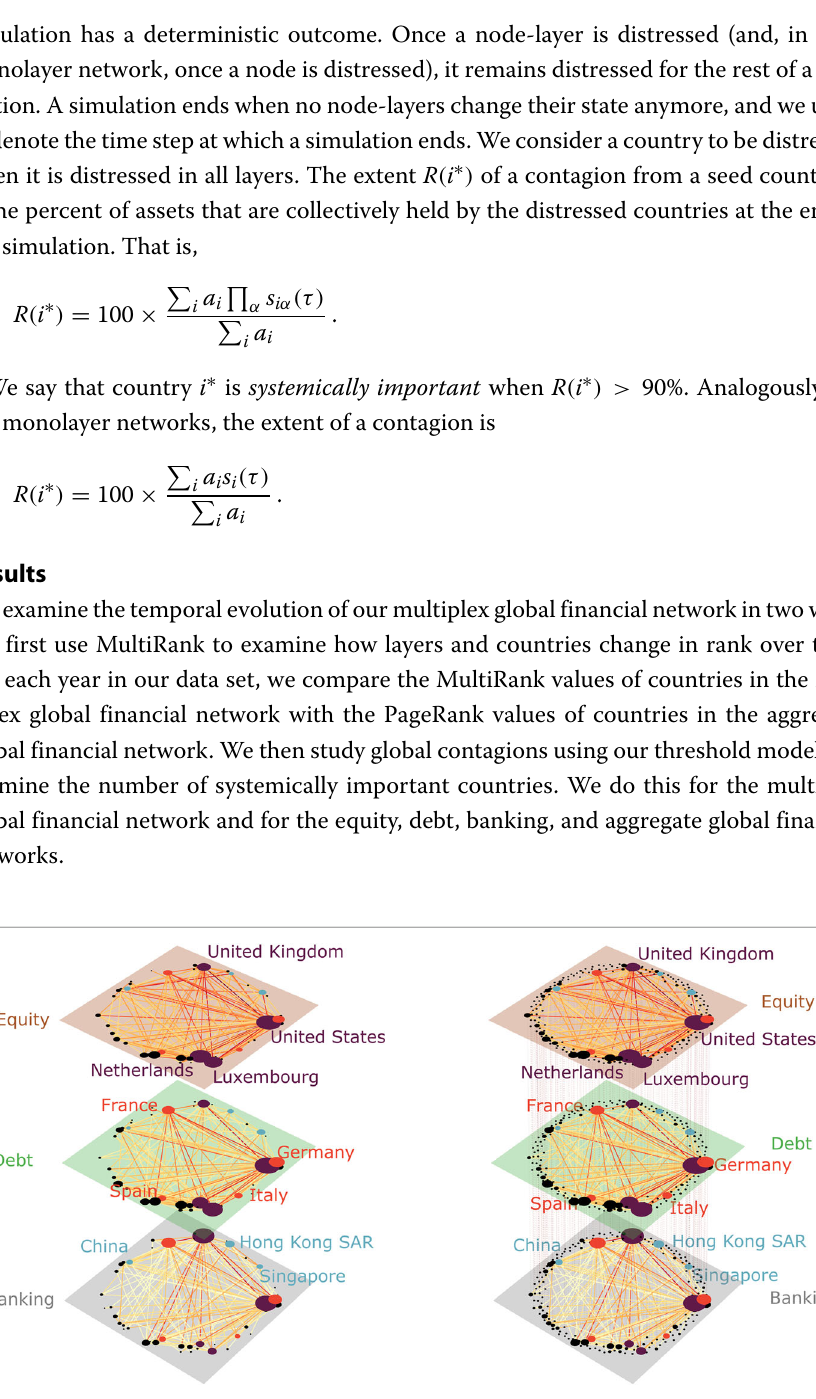
Fig. 2 The multiplex global financial network for 2018. The size of a node is proportional to its degree. For visualization purposes, we show only edges whose weight is ten or more times larger than the mean weight of the edges in the layer. We color the edges based on the natural logarithm of their weight; darker colors indicate larger weights. In the left panel, we show the edge-colored multigraph on which we run MultiRank. In the right panel, we also include interlayer edges that encode the vertical contagion mechanism in our threshold model. All layers have the same layout; in other words, the position of a country is the same in each layer. We label the countries on which we focus our discussion. To avoid overcrowding the figure with labels and because countries have the same positions in all layers, we only label each country in one layer. [We produced the network visualizations using P YMNET (Kivelä 2014) and added labels with I NKSPACE